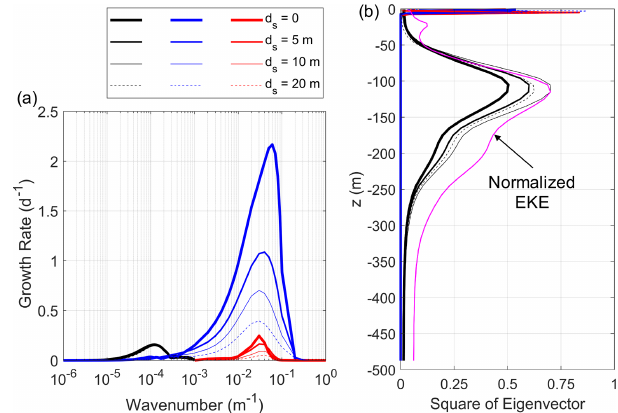
Figure 6. (a) Growth rate ω i of unstable modes as a function of wavenumber for the surface Ekman layer depth d s = 0, 5, 10, and 20m, as well as the bottom Ekman layer depth d b = 20m. Three unstable branches are resolved, including a halocline branch (black) and two surface branches (blue and red). (b) Square of the eigen- vector ˆ ψ 2 of the most unstable mode for each unstable branch. The magenta curve in (b) is the vertical profile of EKE (from Exp-PD, averaged over the final 100d) normalized by the maximum ˆ ψ 2 of the halocline